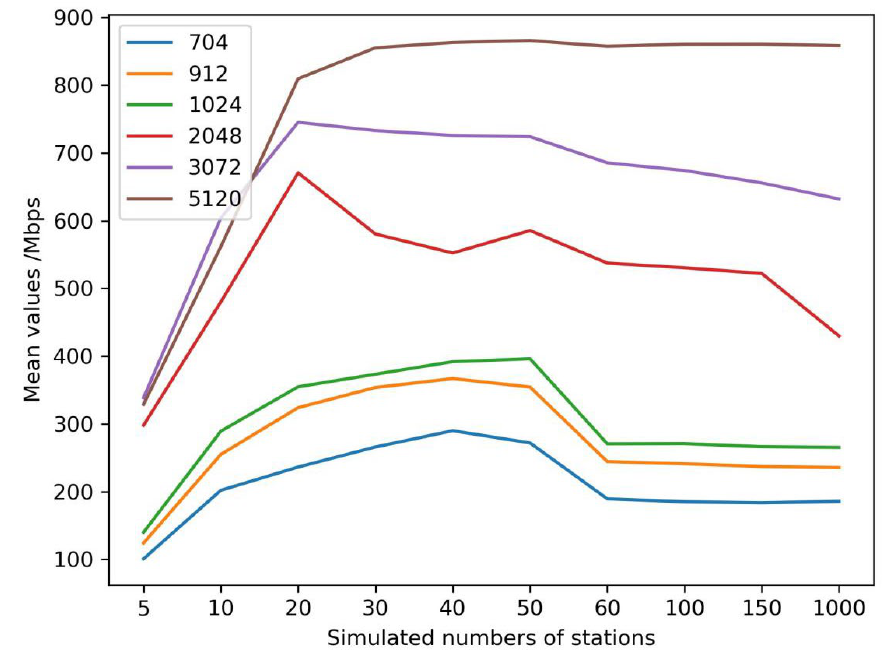
Figure 9. Encryption global rates of different simulated data volumes/bit.